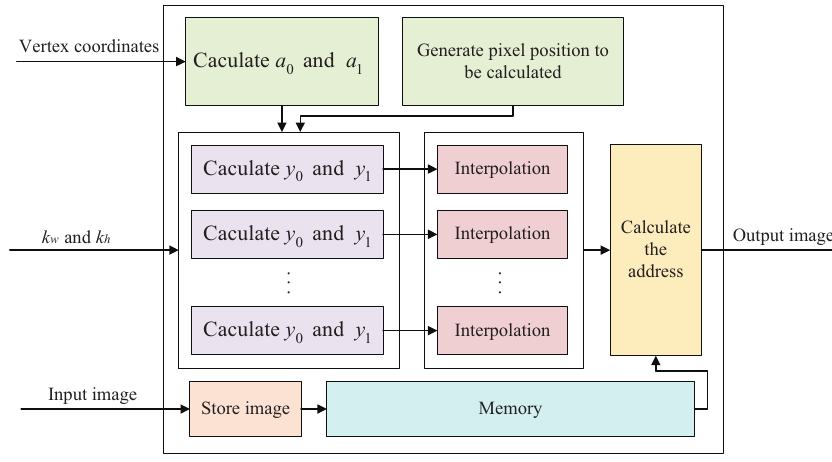
Figure 2. The overall hardware structure of perspective transformation.